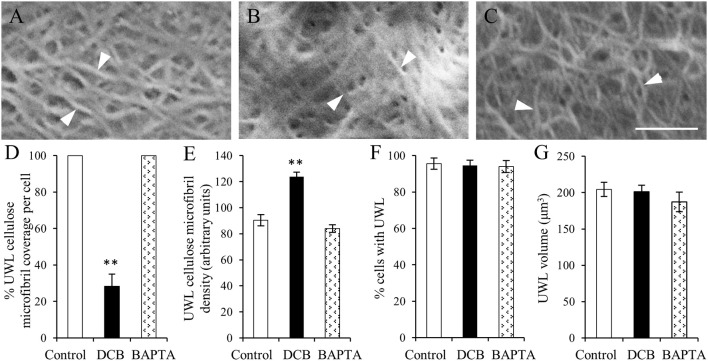
The effect of DCB or BAPTA on, cellulose deposition in, and formation of, the uniform wall layer (A–C). FESEM micrographs of cellulose microfibrils (darts) viewed from the cytoplasmic face of the uniform wall layer in cotyledons cultured for 15 h on MS medium alone (A), MS medium plus 5 μM DCB (B) or MS medium plus 600 μM BAPTA (C). Note (B) is illustrating microfibrils within patches overlaying the original wall resulting from DCB treatment. Bar, 150 nm. (D–G) Effect of DCB and BAPTA on the uniform wall layer with respect to (D) percent coverage with cellulose microfibrils, (E) relative densities of cellulose microfibrils determined across the entire outer periclinal surface for control and BAPTA-treated cells and for the patches of cellulose microfibrils formed in response to DCB treatment (for more information, see Materials and Methods), (F) percent epidermal cells forming the uniform wall layer, and (G) its volume per cell. Means ± SEs (bars) of four to five replicate cotyledons, 40 to 200 determinations per replicate depending upon type of measurement. Asterisk indicates a significant difference (Student's t-test, **P < 0.01) with percentage data arc sine transformed for the analysis.